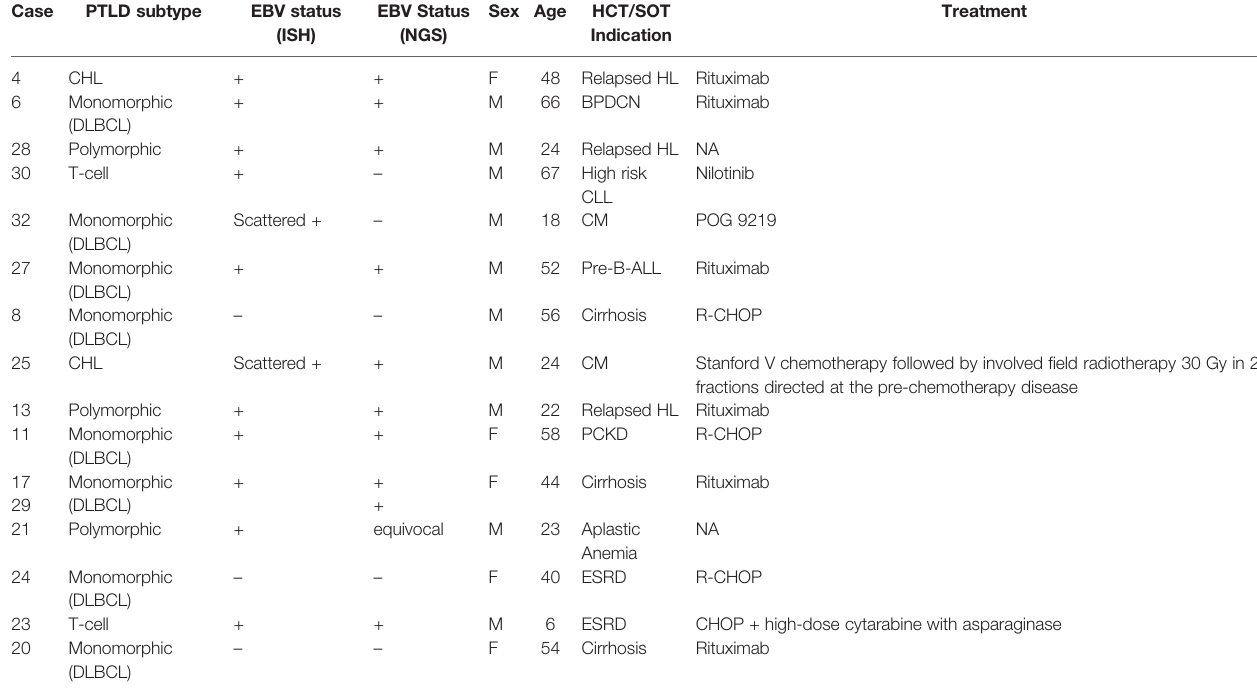
TABLE 1 | Clinical and histological characteristics of the PTLD patients included in